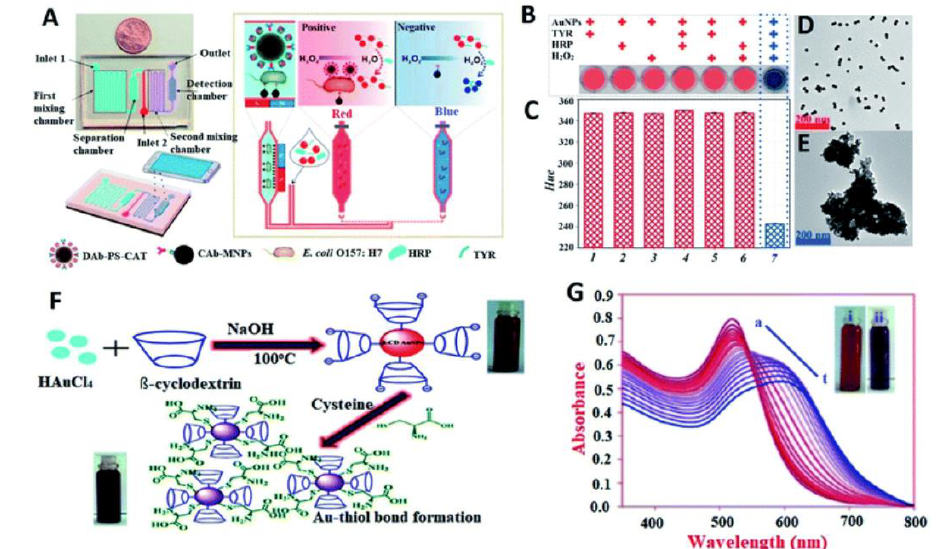
Figure 6: Smartphone based GNP optical biosensor for colorimetric assays for E. coli. (A) Labelled diagram of the biosensor; (B) result of mixing GNPs with various cross-linking agents; (C) Hues of colour changed; (D) TEM image before aggregation; (E) TEM image after aggregation; (F) Schematic of functionality of biosensor; (G) SPR band changes